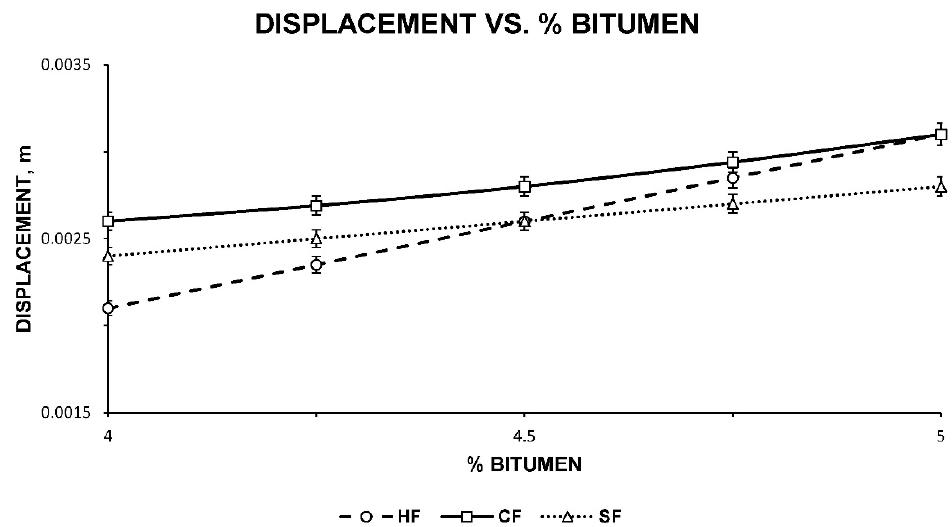
Figure 9. Marshall deformation of the HF, CF and SF families of bituminous mixtures according to the percentage of bitumen.